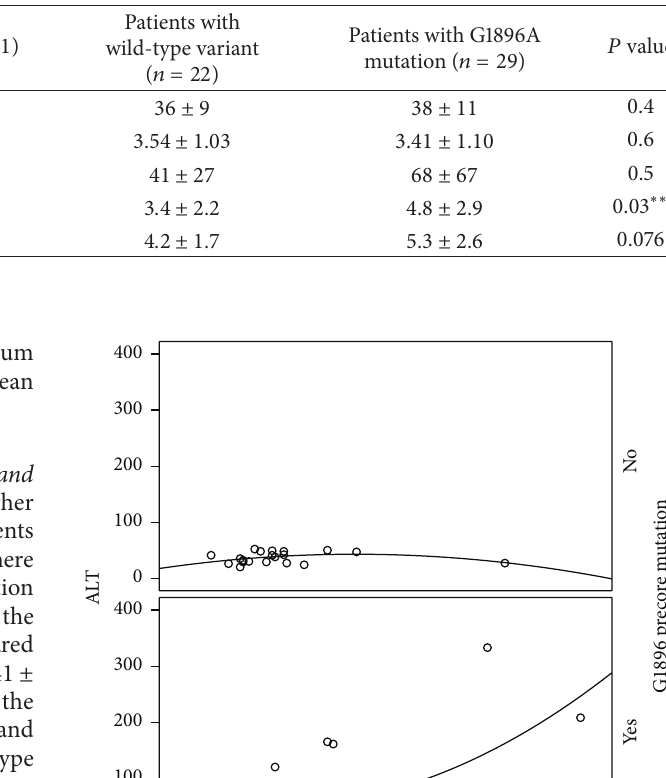
Table 1: Clinical and pathological data of 51 chronic hepatitis B patients with and without precore mutation G1896A.